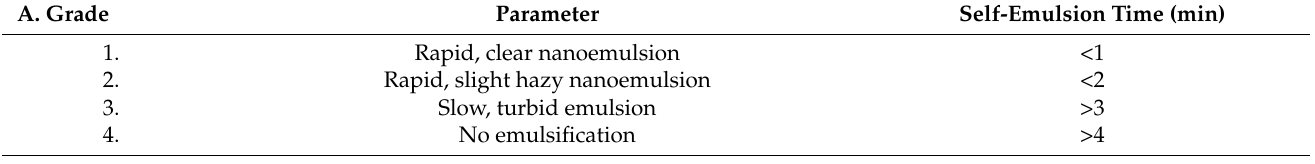
Table 1. ( A ). Grading system of oil and Smix based on appearance and emulsification time. ( B ). Visual screening data of nano emulsions using different ratio of Smix and